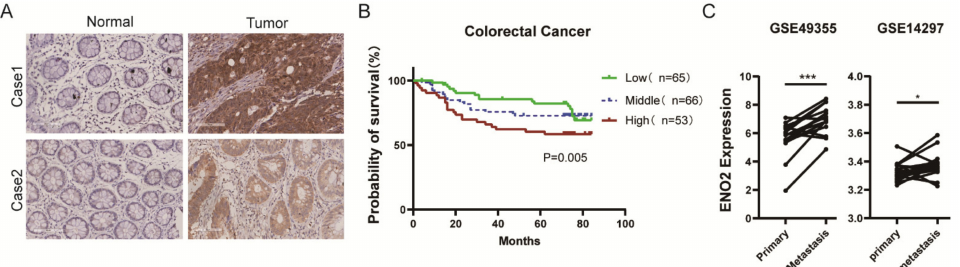
Figure 1. ENO2 was upregulated in CRC tissues and negatively correlated with poor prognosis. ( A ): Representative immunohistochemical staining of the ENO2 protein in CRC samples and in the corresponding adjacent normal tissue. ( B ): Overall survival analysis in 184 CRC patients with low ( n = 66), middle ( n = 65) or high ( n = 53) levels of ENO2 by Kaplan–Meier analysis. ( C ): GEO analysis (GSE49355 and GSE14297) (http://www.ncbi.nlm.nih.gov/geo/ (accessed on 6 April 2020). * p < 0.05, *** p <